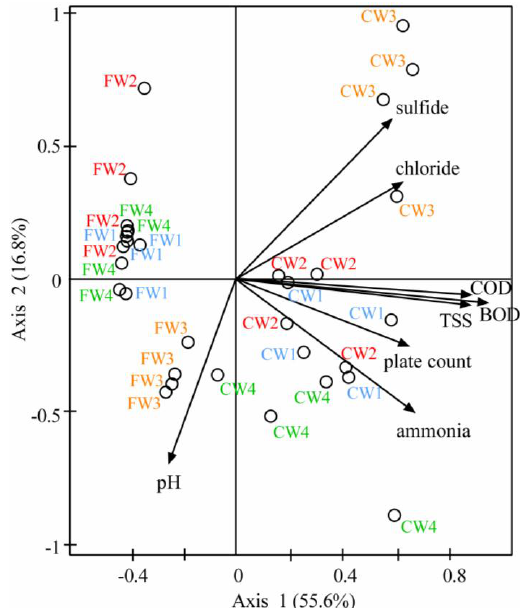
Figure 3. Results from multivariate analysis. Ordination diagram of thirty two wastewater samples from four wastewater treatment plants (WWTPs) (Site 1 in blue, Site 2 in red, Site 3 in orange and Site 4 in green) obtained by canonical correlation analysis considering height biochemical parameters (BOD, COD, TSS, ammonia, pH, chloride, sulfide and total plate count) as environmental variables constrained by one explanatory variable, the derived IC 50 values at 1